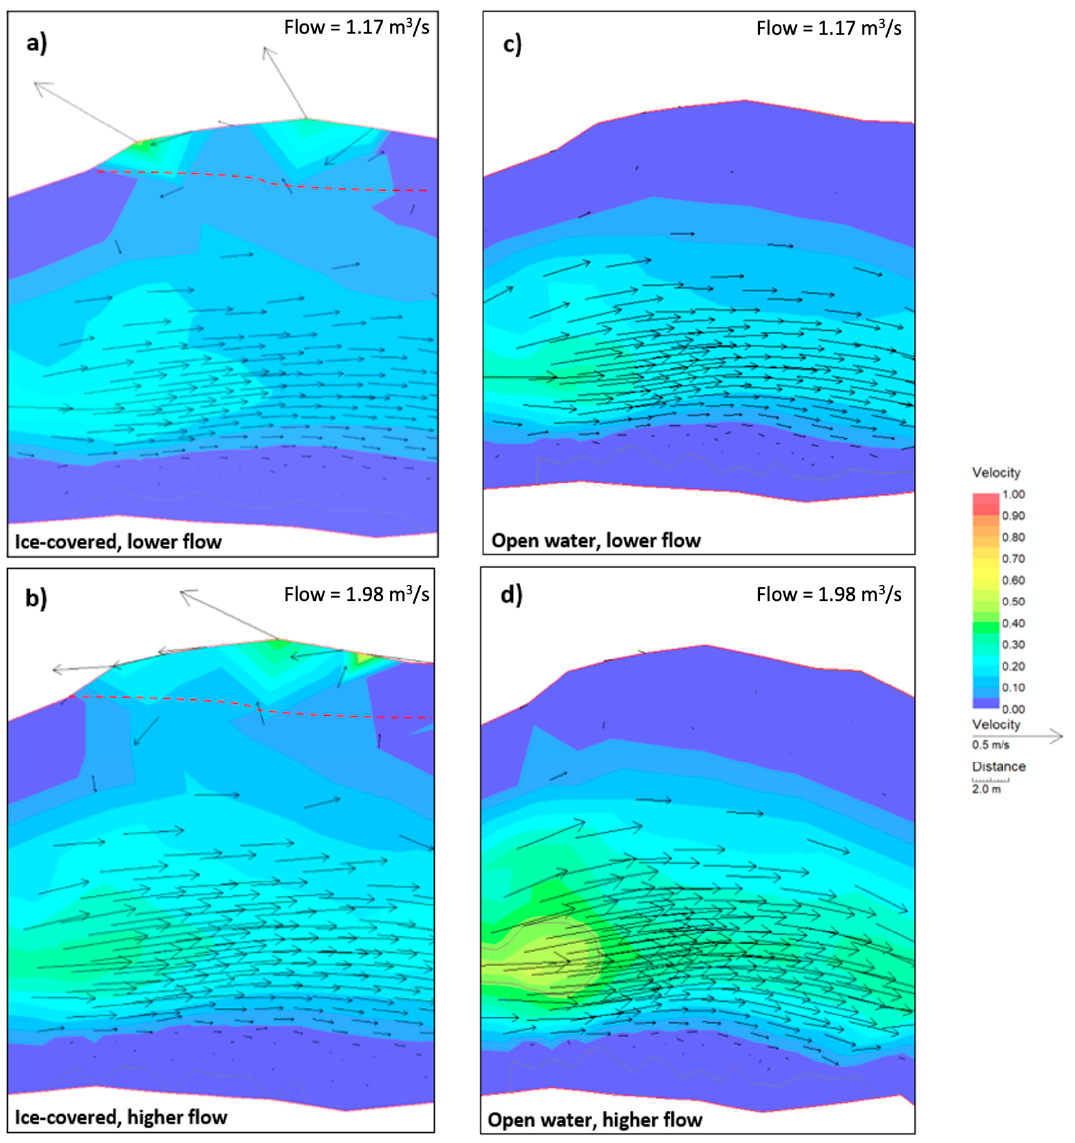
Figure 7. Resampled depth-averaged velocity magnitude and directions within the pool under ( a ) lower flow, ice-covered conditions; ( b ) lower flow, open-water conditions; ( c ) higher flow, ice-covered conditions; and ( d ) higher flow, open-water conditions. Flow directions are indicated using vector arrows at each mesh point, set at 1 m intervals. Ice extent along the left bank is delineated by dashed line in ( a , c ). Prepared in River2D.